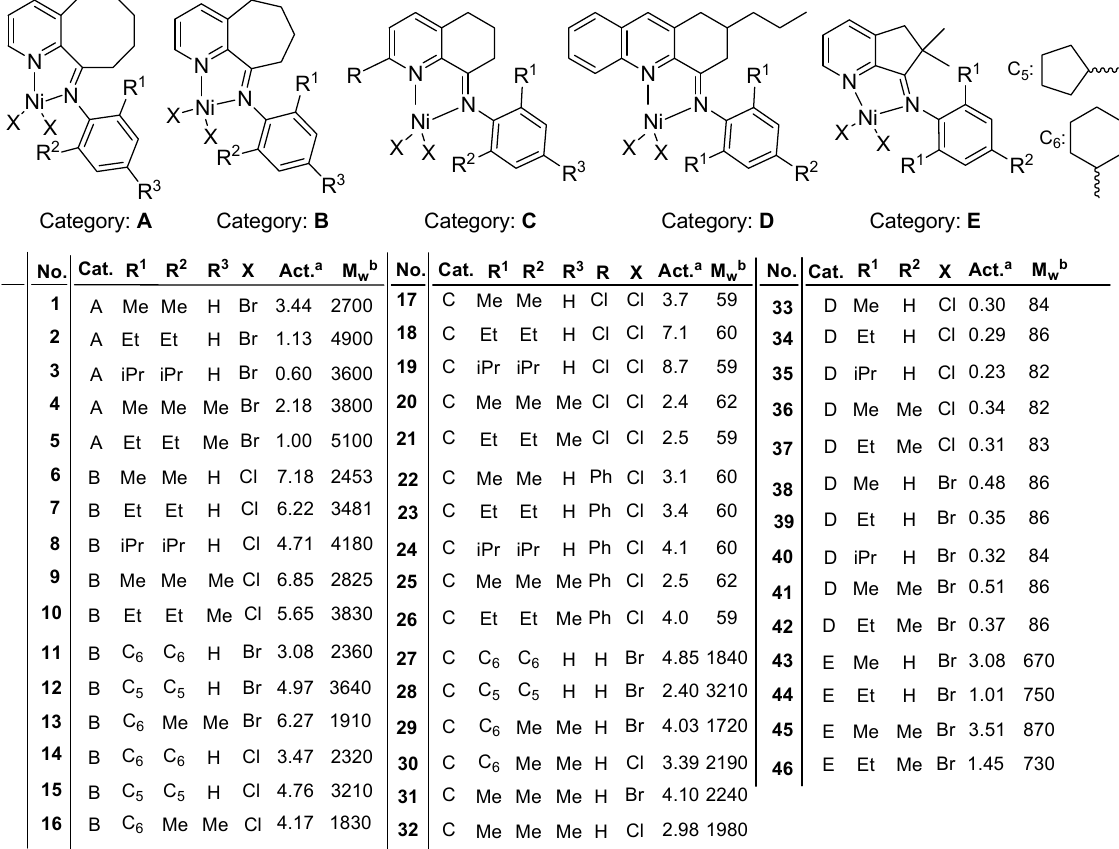
Scheme 1. Structures of the initial data set for 46 nickel complex precatalysts along with their catalytic activities and molecular weight of produced polyethylene under the optimum conditions. a , 10 6 g · mol − 1 · h − 1 , b , g · mol − 1 .